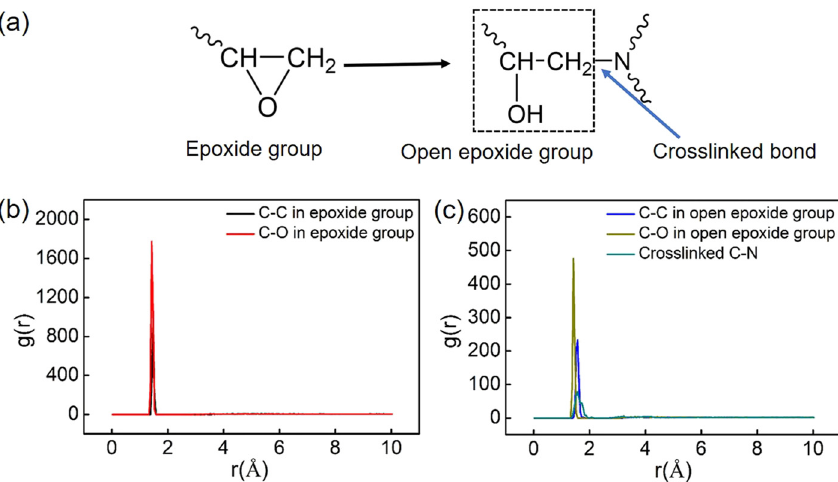
Figure 5: ( a ) The schematic diagram of bond change during cross - link. ( b ) The partial RDF of bonds in the epoxide group. The lengths of C – C and C – O bonds are 1.48 and 1.43 Å, respectively, close to those measured by experiments. ( c ) The partial RDF bonds in open epoxide groups. The lengths of C – C and C – O bonds are 1.58 and 1.43 Å. The cross - linked C – N bond between DGEBA monomer and 44DDS monomer is about 1.53 Å.